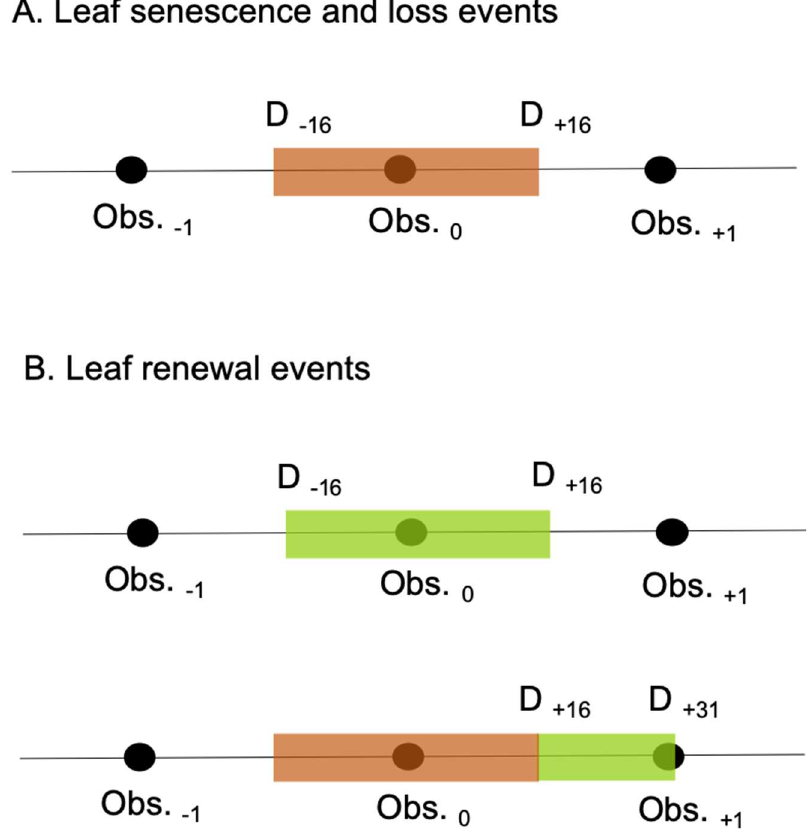
Figure 1. Converting point observations to periods of leaf turnover. ( A ) Leaf senescence and loss events are defined as starting 16 days prior (D -16 ) to the first observation of leaf senescence or loss and ending 16 days after (D + 16 ) the last observation of the same (in this example, the first and last observations of leaf senescence or loss are the same: Obs. 0 ). ( B ) Leaf renewal events are defined as starting 16 days prior (D- 16 ) to the first observation of new leaves and ending 16 days after (D + 16 ) the last observation of the same, or 16 to 31 days after (D + 16: + 31 ) the last observation of leaf senescence or loss on occasions when new leaves are not directly observed. The colored rectangles indicate the likely periods of either leaf senescence and loss (brown) or leaf renewal (green) calculated in this way. The central wavelengths for the Sentinel-2 bands are as follows: Band 2 (blue): 0.490 nm; band 3 (green): 0.560 nm; band 4 (red): 0.705; band 8 (near infrared): 0.865. We then further masked any